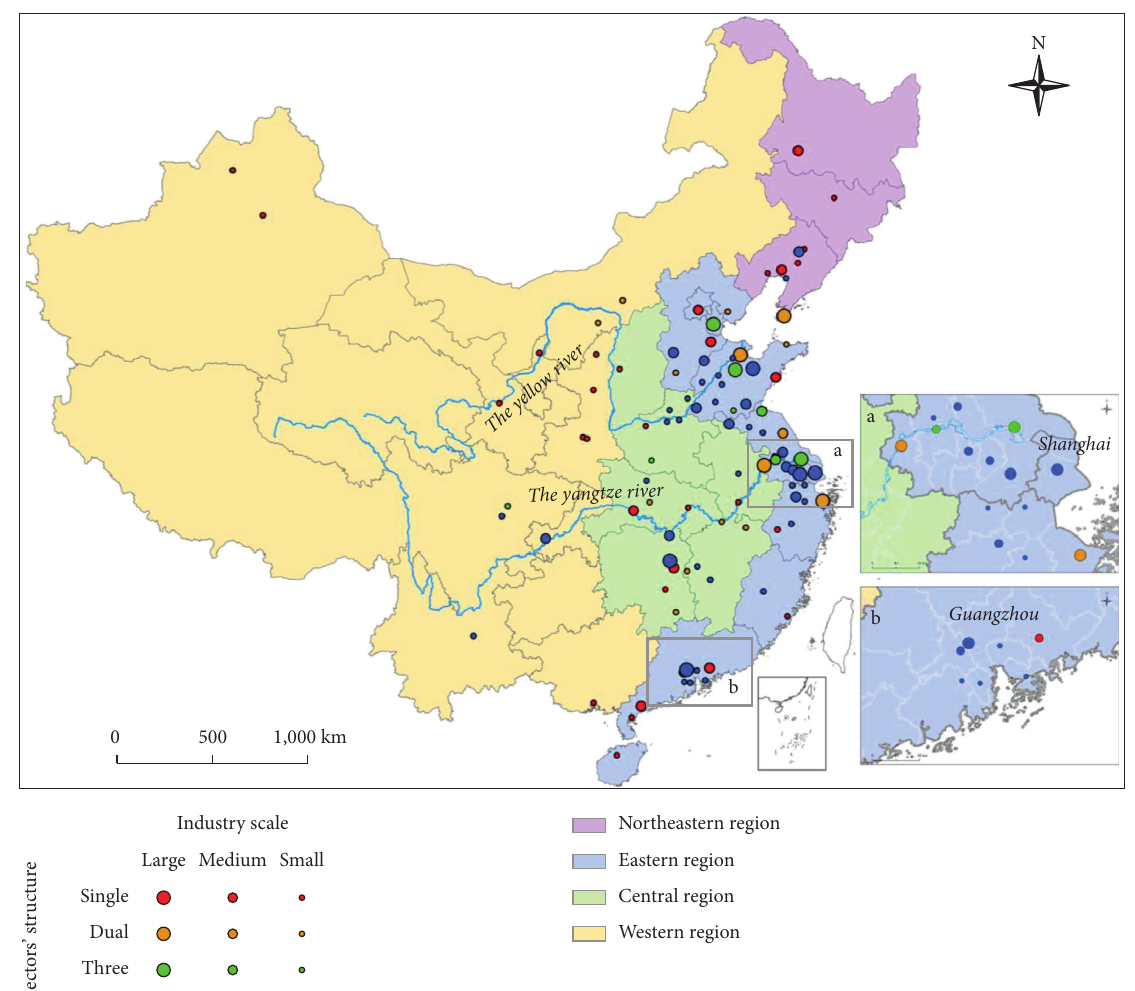
Figure 3: Spatial and type distribution of CICs in China,